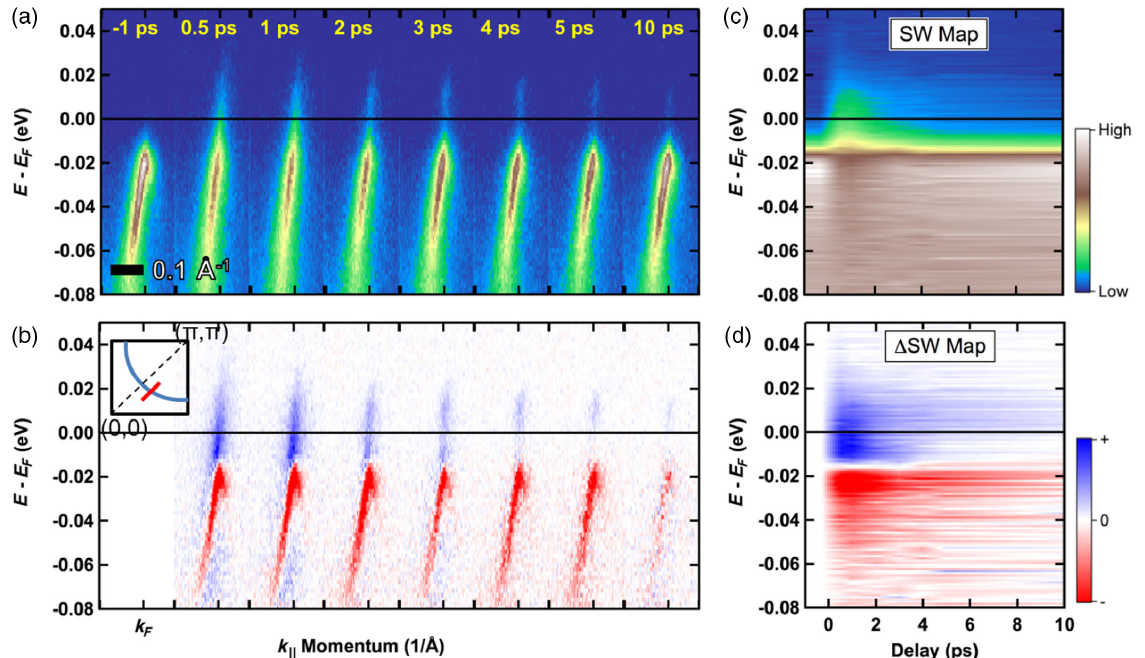
eye.FIG. 2. Off-node [inset to panel (b)] gapped spectra at various pump-probe delays from the same T C ¼ 91 K sample as Fig. 1, with all panels the same as in Fig. 1. The equilibrium temperature is 20 K, and the pump fluence is 80 μ J = cm 2 . Note in panel (d) how the region inside the gap recovers (returns to white) faster than the region at the gap